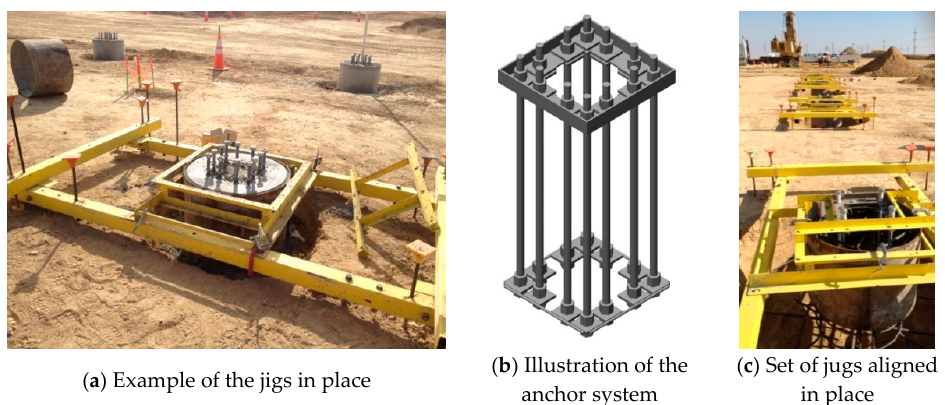
Figure 3. Jigs to position the anchors at the foundations (Source: ConXtech, used with permission from Kelly Luttrell).